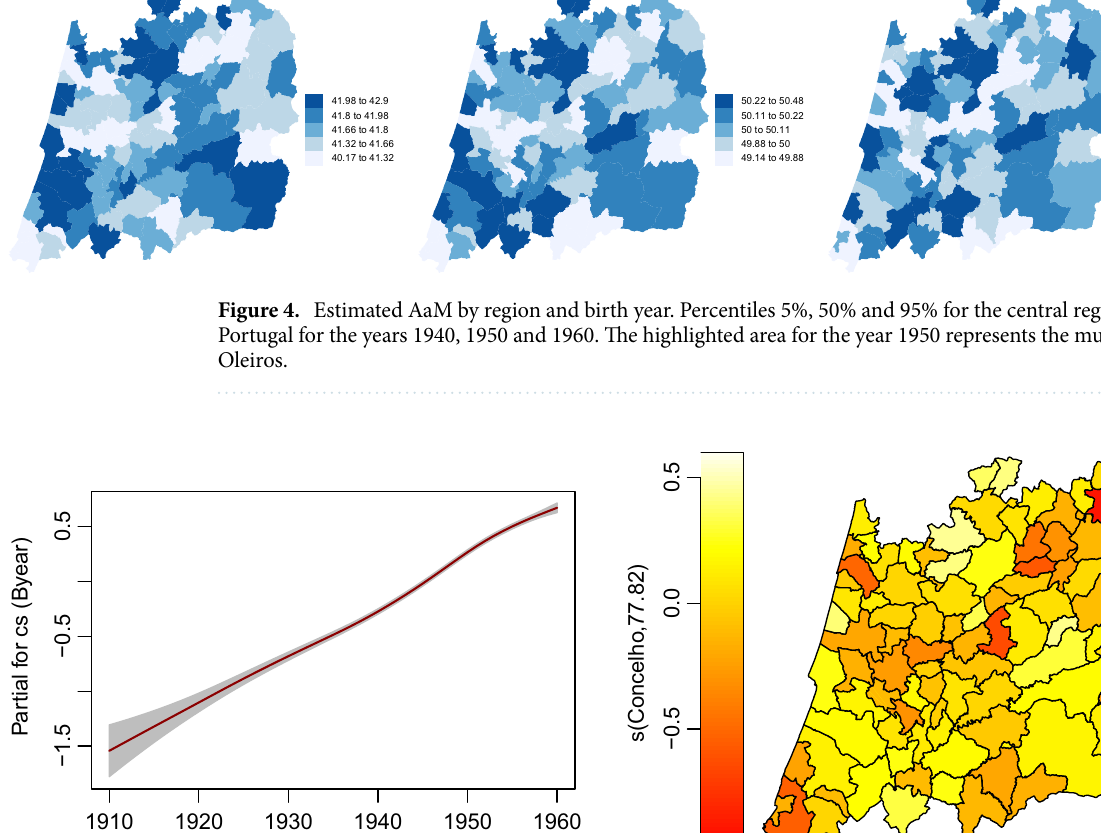
Figure 5. Estimated effects for the age at menopause model showing the temporal variation of the birth year effects (left) together with the clustered spatial effects